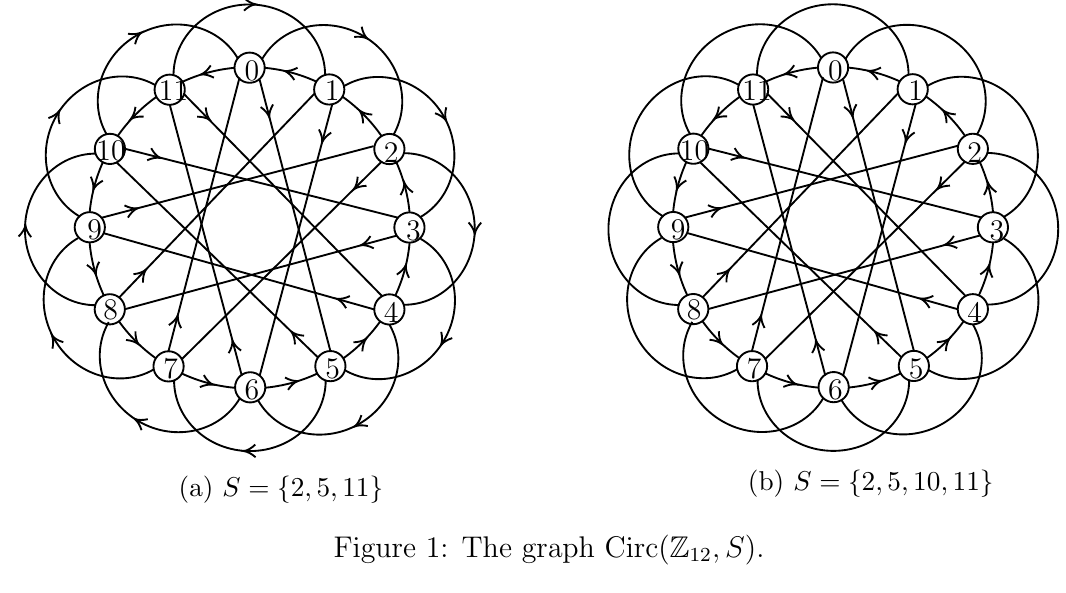
Figure 1: The graph Circ( Z